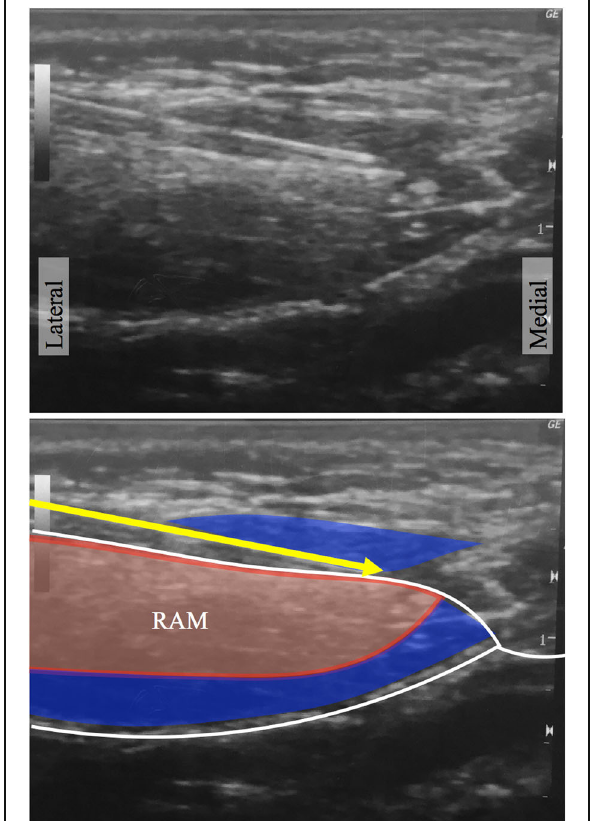
Fig. 2 The injection in the subcutaneous tissue. The tip of the needle ( yellow arrow ) is in the subcutaneous space around the umbilicus. The depositions of injected local anesthetic ( blue ) are also observed inside the rectus sheath. RAM rectus abdominis